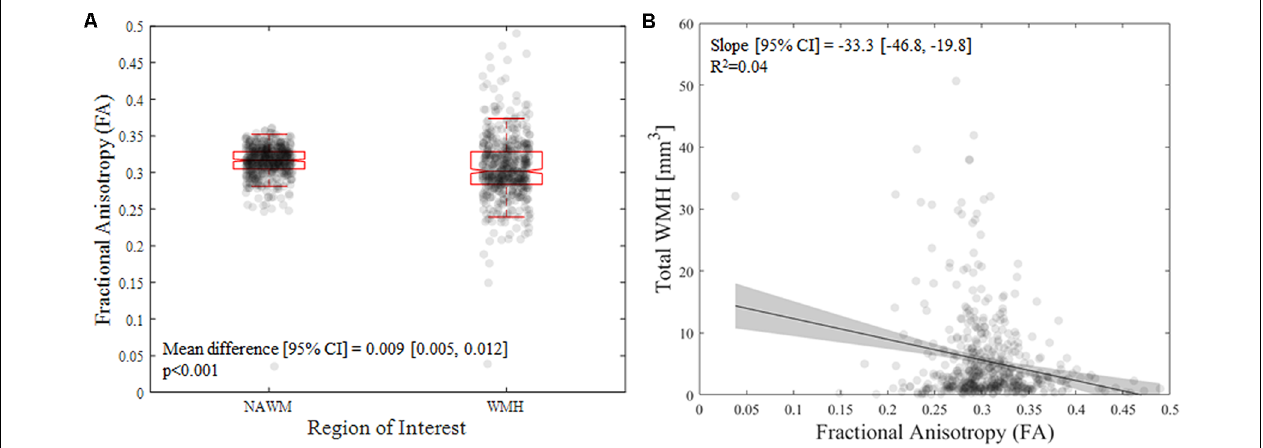
FIGURE 1 | (A) Difference in mean fractional anisotropy (FA) value between nomal appearing white matter (NAWM) and white matter hyperintensities (WMH) in the older sample. (B) Association of mean FA value with WMH and the total WMH volume in the older sample.